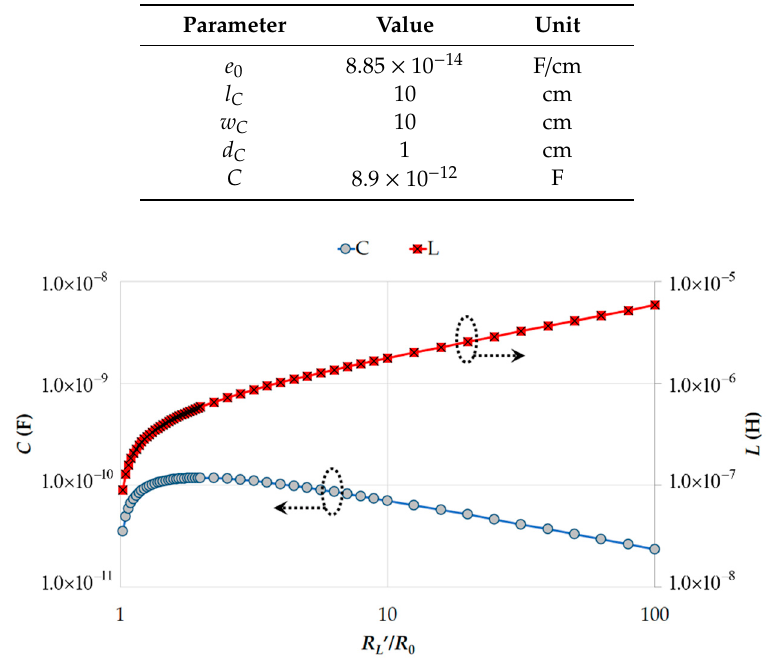
Figure 6. Capacitance and inductance behaviors under various impedance values.